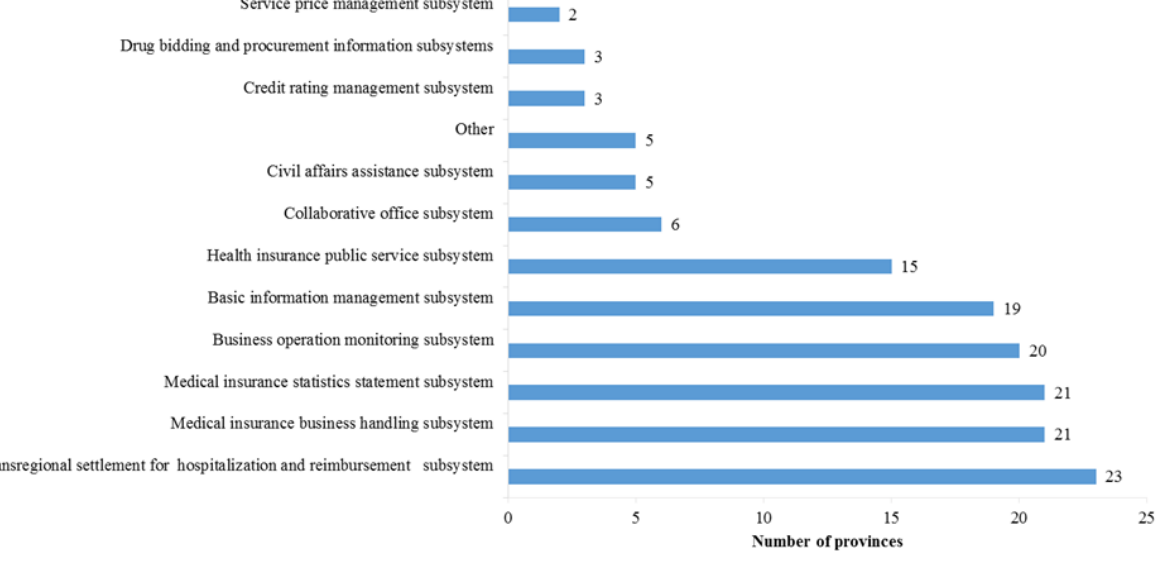
Figure 4. Distribution of business function modules used in various provinces in China according to questionnaire